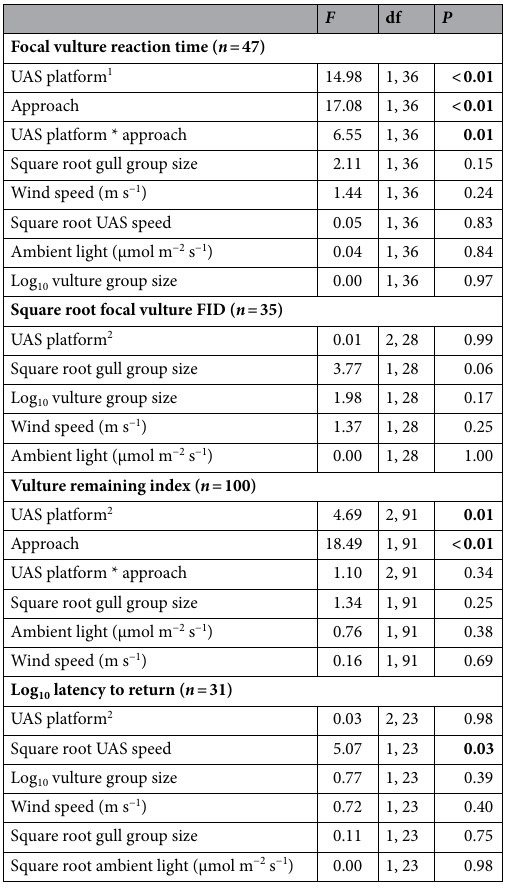
Table 2. Results from general linear models type III sums of squares analyses of turkey vulture responses to UAS approach. For UAS platform, the categories were fixed-wing, multirotor, and ornithopter and approach included targeted or overhead. Trials were conducted at the Erie County Landfill, Ohio, between July and September 2019. Significant results are marked in bold. 1 Multirotor and fixed-wing. 2 Multirotor, fixed-wing and